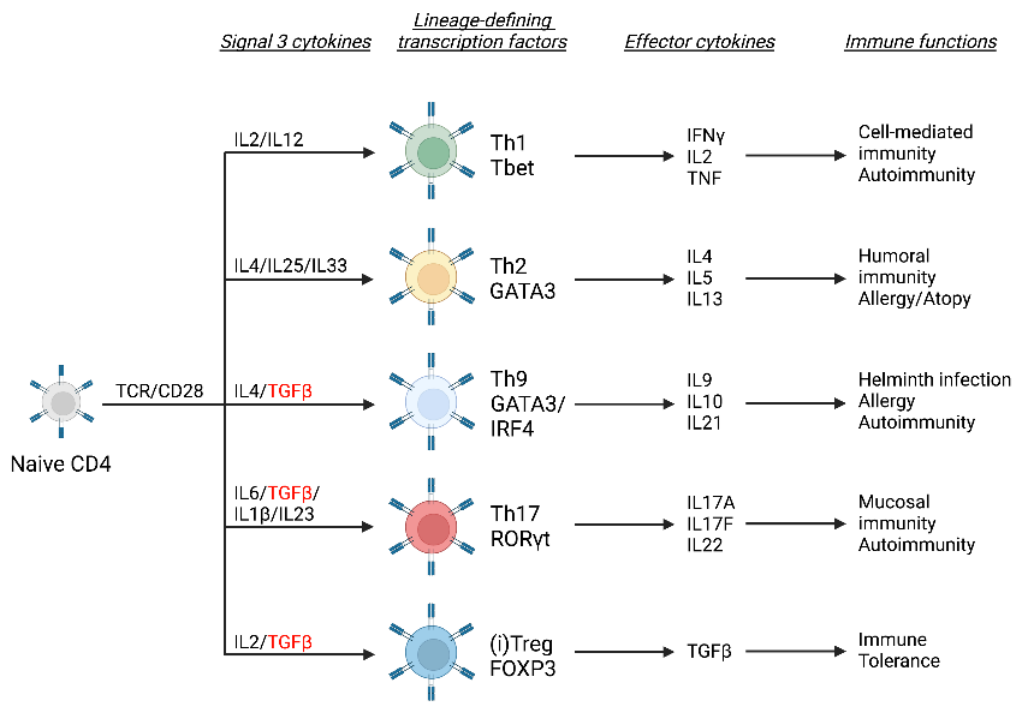
Figure 1. Role of TGF β in differentiation of CD4 + T helper cells. Upon activation through TCR, costimulatory CD28 and cytokine-driven signaling, naïve CD4 + T cells adopt specialized Th cell phenotypes. Expression of lineage-defining transcription factors and effector cytokines enables distinct Th subsets to function in diverse immune responses, as depicted. Image created in Biorender.com.